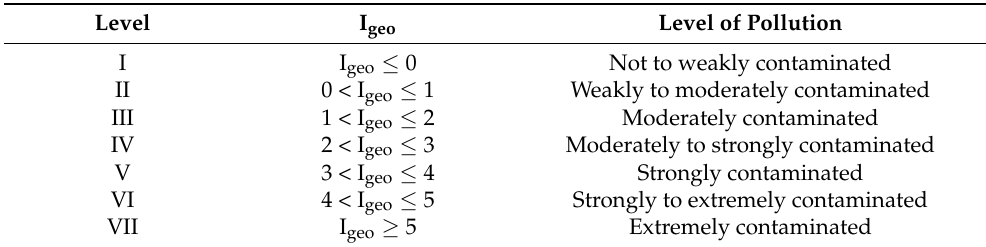
Table 3. Geoaccumulation index with different